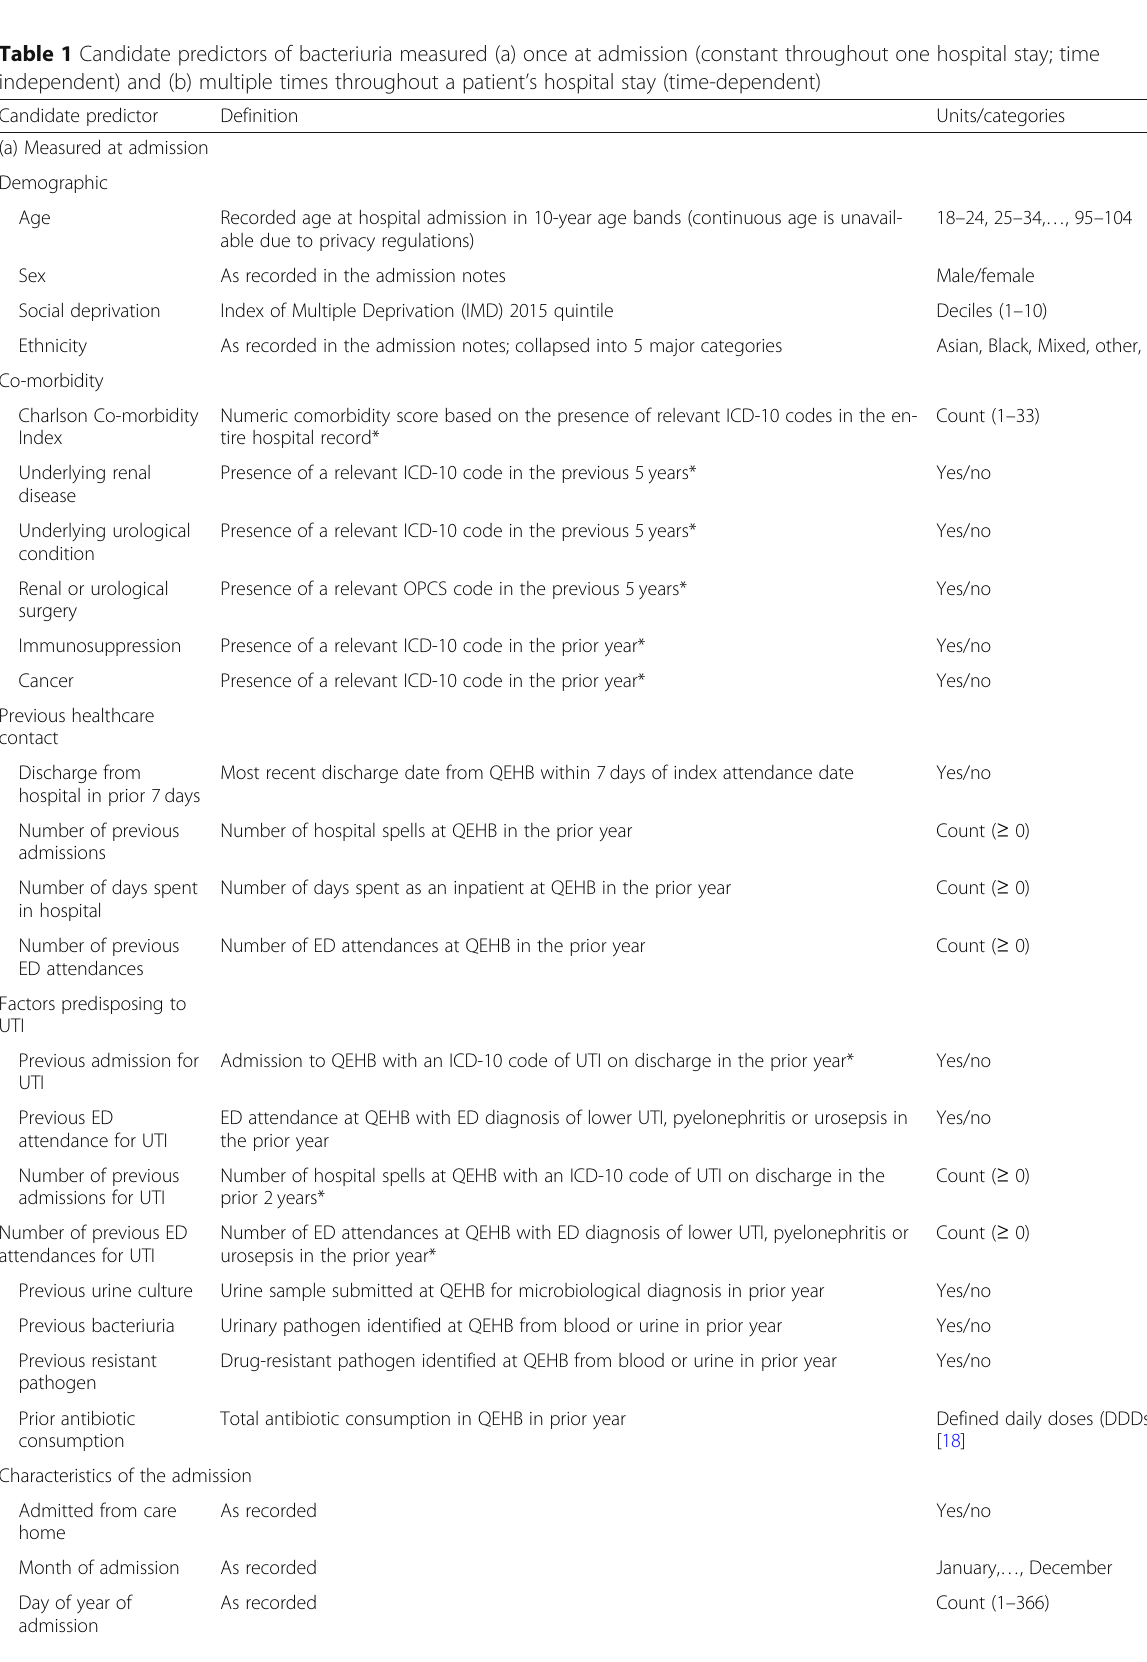
Table 1 Candidate predictors of bacteriuria measured (a) once at admission (constant throughout one hospital stay; time independent) and (b) multiple times throughout a patient ’ s hospital stay